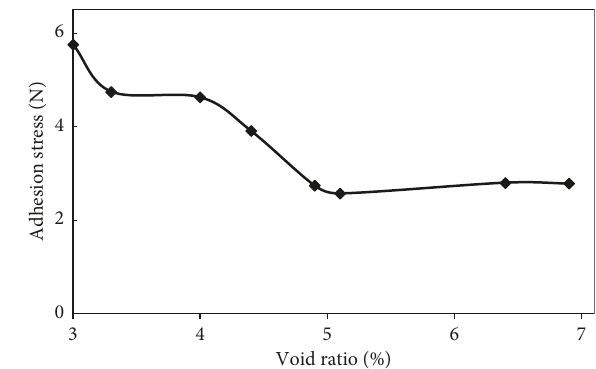
Figure 13: Adhesion test results of different specimens.